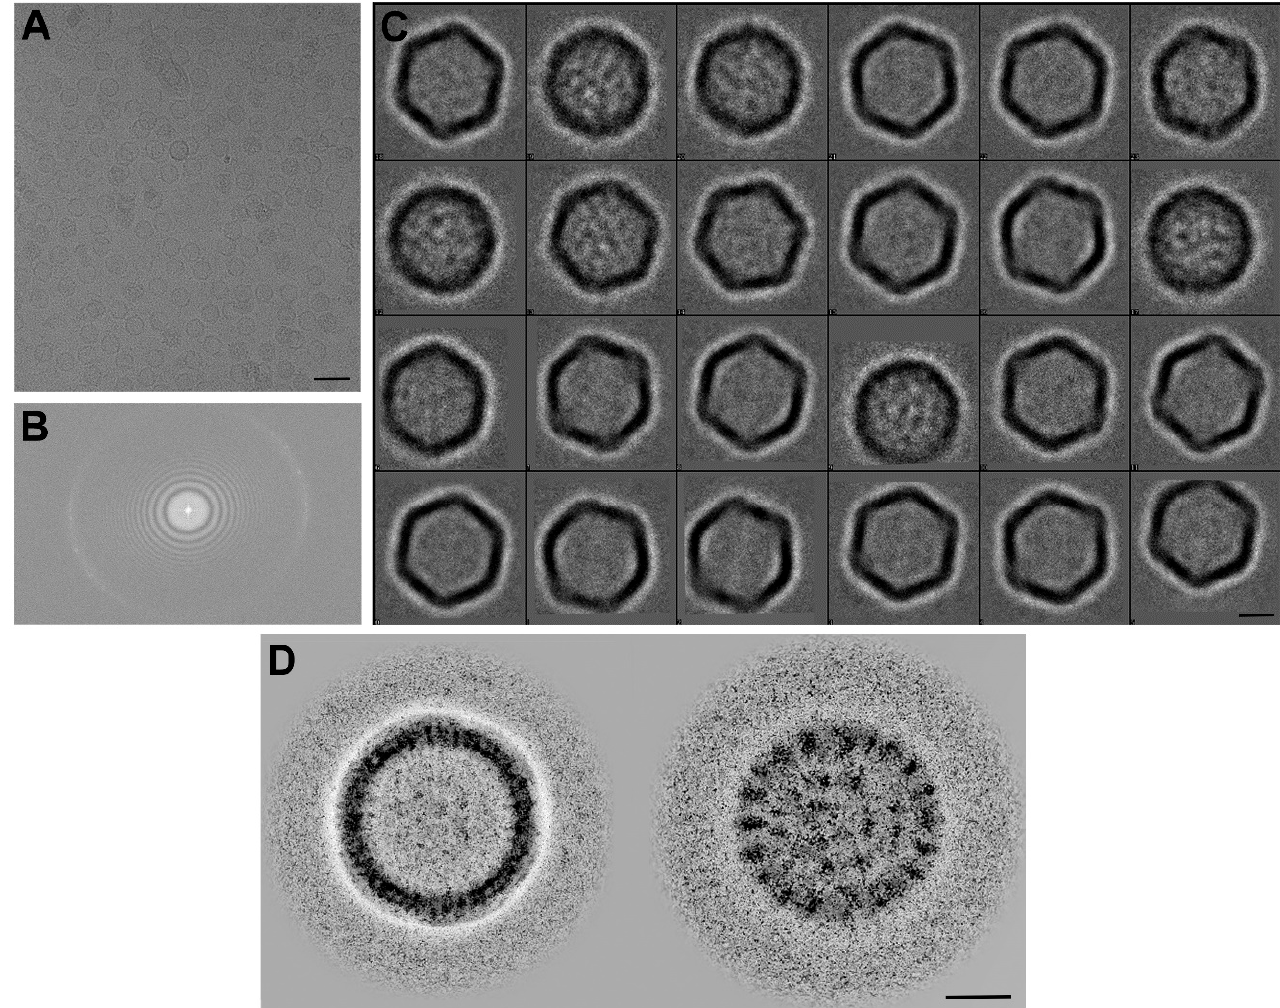
Figure 2. Representative cryoTEM image ( A ), its power spectrum ( B ), and the selected particles ( C ) for class averaging by EMAN2 (2D analysis) and CisTEM1 software. Panel ( D ) demonstrates two subclasses of particles (shown by the back-projections of reconstructions), including empty and genome-filled particles, which showed different electron densities in the VLP cavity. Bars in ( A ) = 50 nm, ( C , D ) = 10 nm.